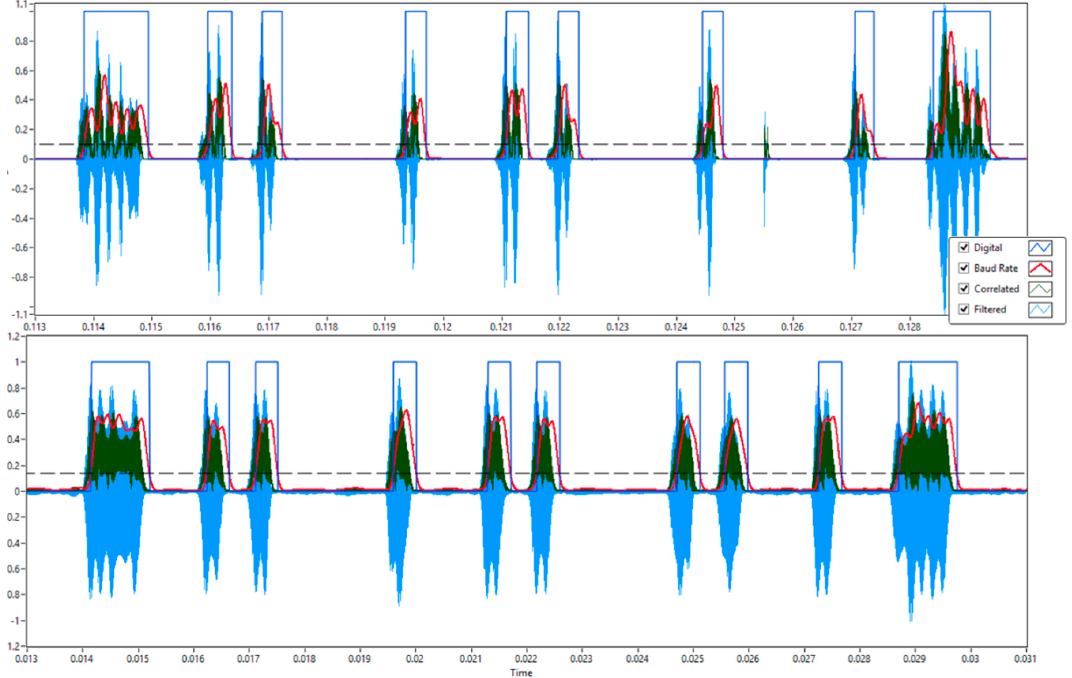
Figure 13. Digital signal processing (DSP) and signal digitalization of a symbol (4BH) identification over 1 m cable, upper trace, and 10 m cable, lower trace.